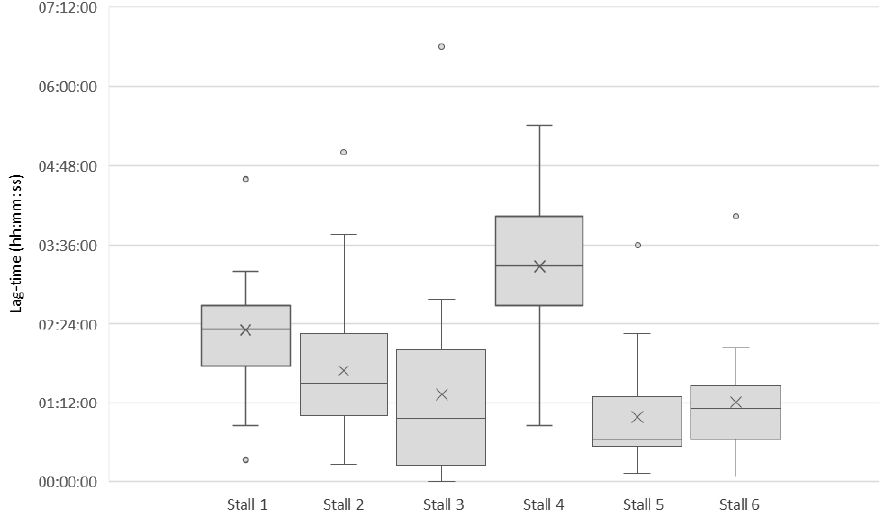
Figure 5. Variation in VR event to experimental stalls 1–6 displayed by quantiles, minimum and maximum values and outliers as a box-and-whisker plot.